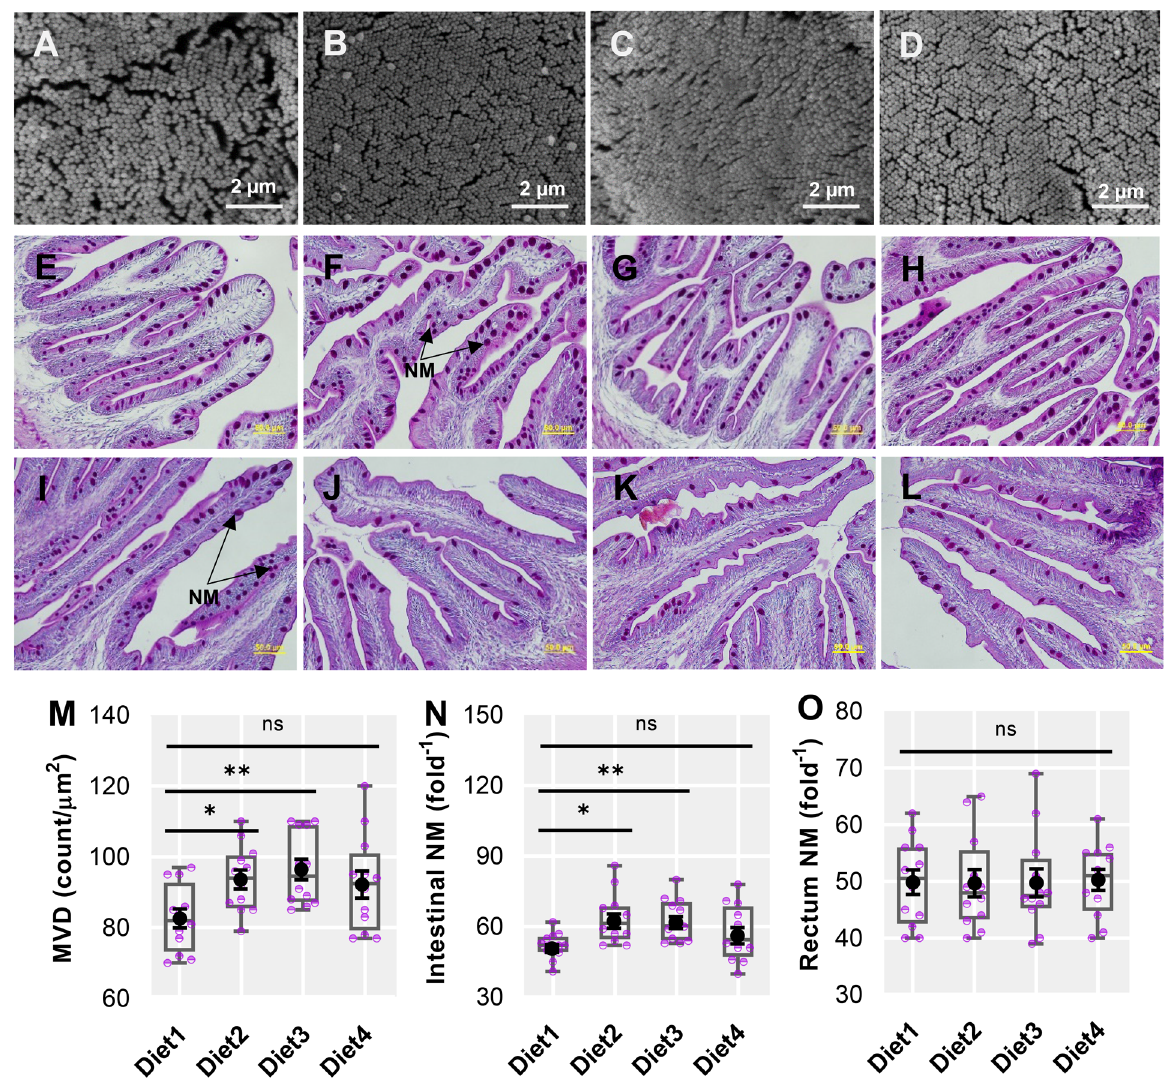
Figure 2. Scanning electron micrographs ( A – D ) to visualize the microvilli density and goblet cells containing neutral mucins ( E – H , PAS stain, 40 × magnification) in the distal intestine ( E – H ) and rectum ( I – L ) of barramundi fed Control (Diet1), 80PBM 10TH+10HI (Diet2), 85PBM 5TH+10HI (Diet3), and 90PBM 5TH+5HI (Diet4) for six weeks. Variation in the microvilli density (M) and neutral mucins in the distal intestine ( N ) and rectum ( O ) of barramundi fed test diets. Multiple comparisons were performed by one-way ANOVA analysis followed by Dunnett’s multiple comparisons test. NM, neutral mucins and ns, not